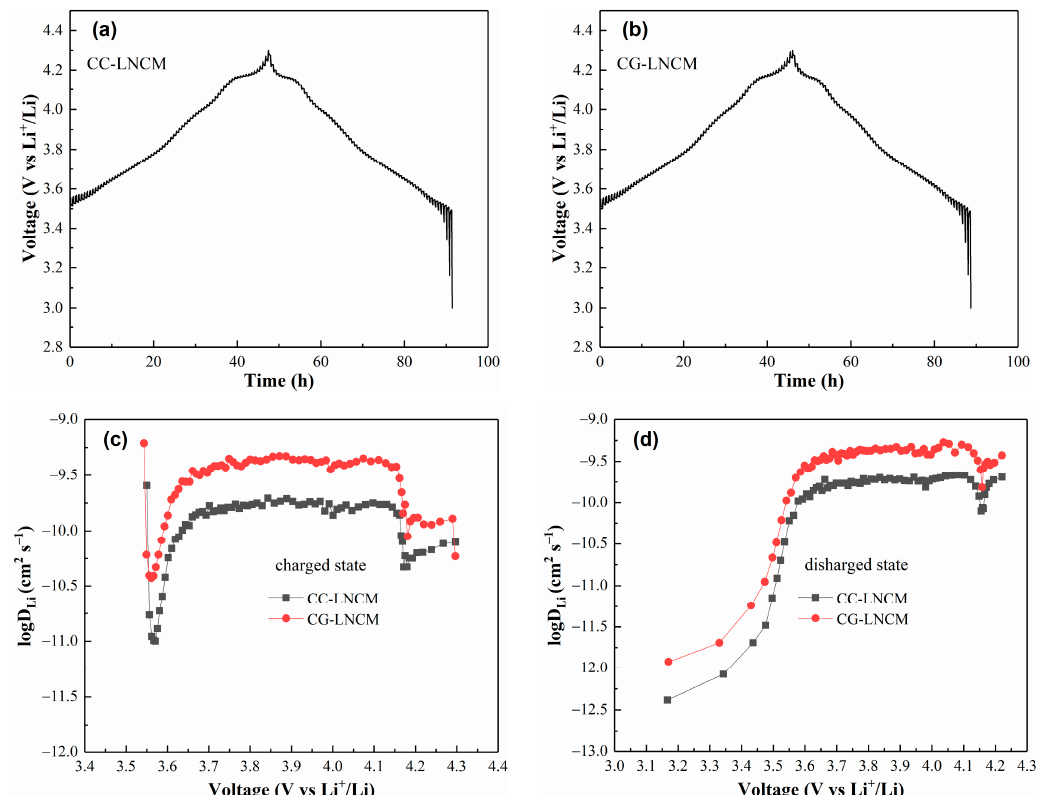
Figure 8. GITT curves of ( a ) CC-LNCM and ( b ) CG-LNCM, relationship between voltage and Li + di ff usion coe ffi cient of CC-LNCM and CG-LNCM at ( c ) charged state and ( d ) discharged state.